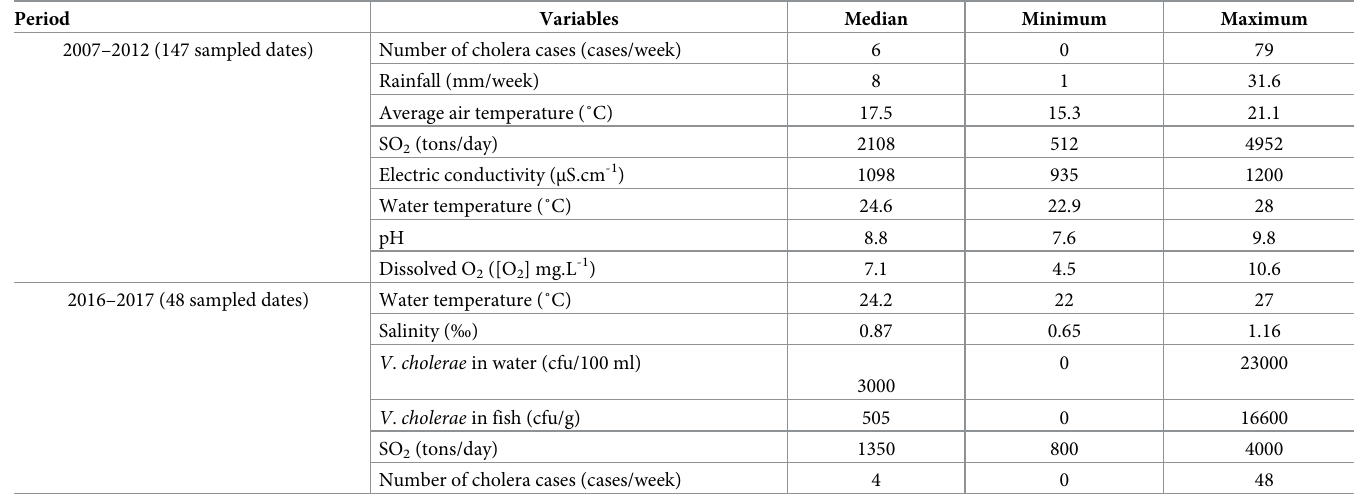
Table 1. Summary of data collected during the two sampling periods.